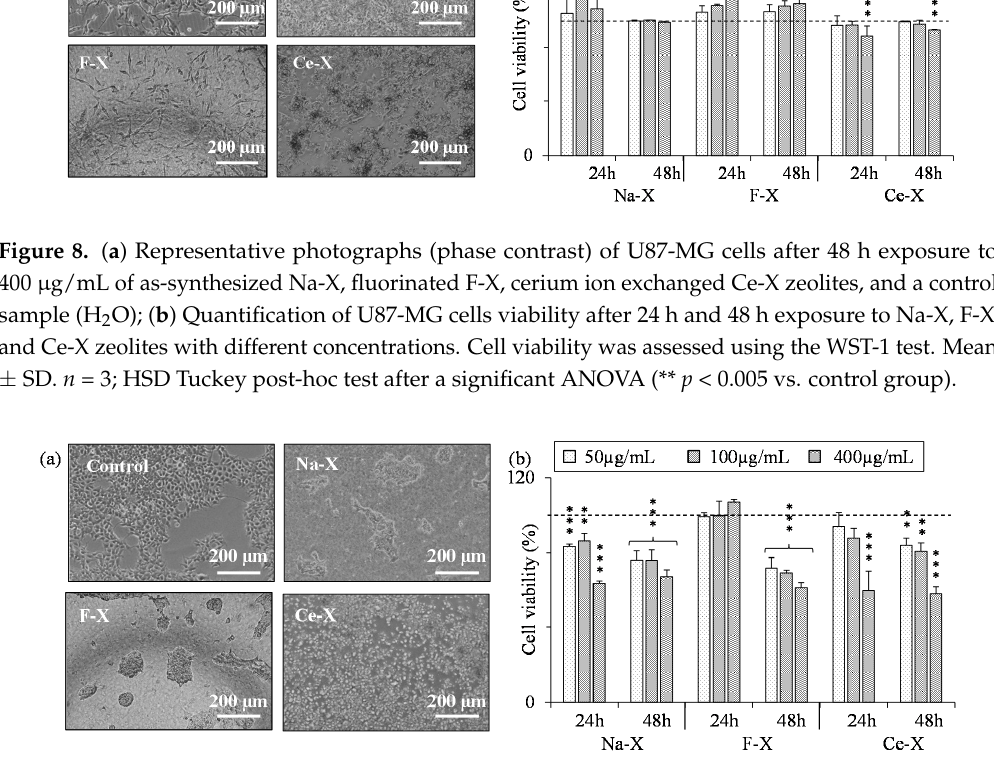
Figure 9. ( a ) Representative photographs (phase contrast) of HEK 293T cells after 48 h exposure to 400 µg/mL of as-synthesized Na-X, fluorinated F-X, the cerium ion exchanged Ce-X zeolites, and a control sample (H 2 O); ( b ) Quantification of HEK 293T cells viability after 24 h and 48 h exposure to Na-X, F-X, and Ce-X zeolites with different concentrations. Cell viability was assessed using the WST-1 test. Mean ± SD. n = 3; HSD Tuckey post-hoc test after a significant ANOVA (* p < 0.05; ** p < 0.005; *** p < 0.0005 vs control group).